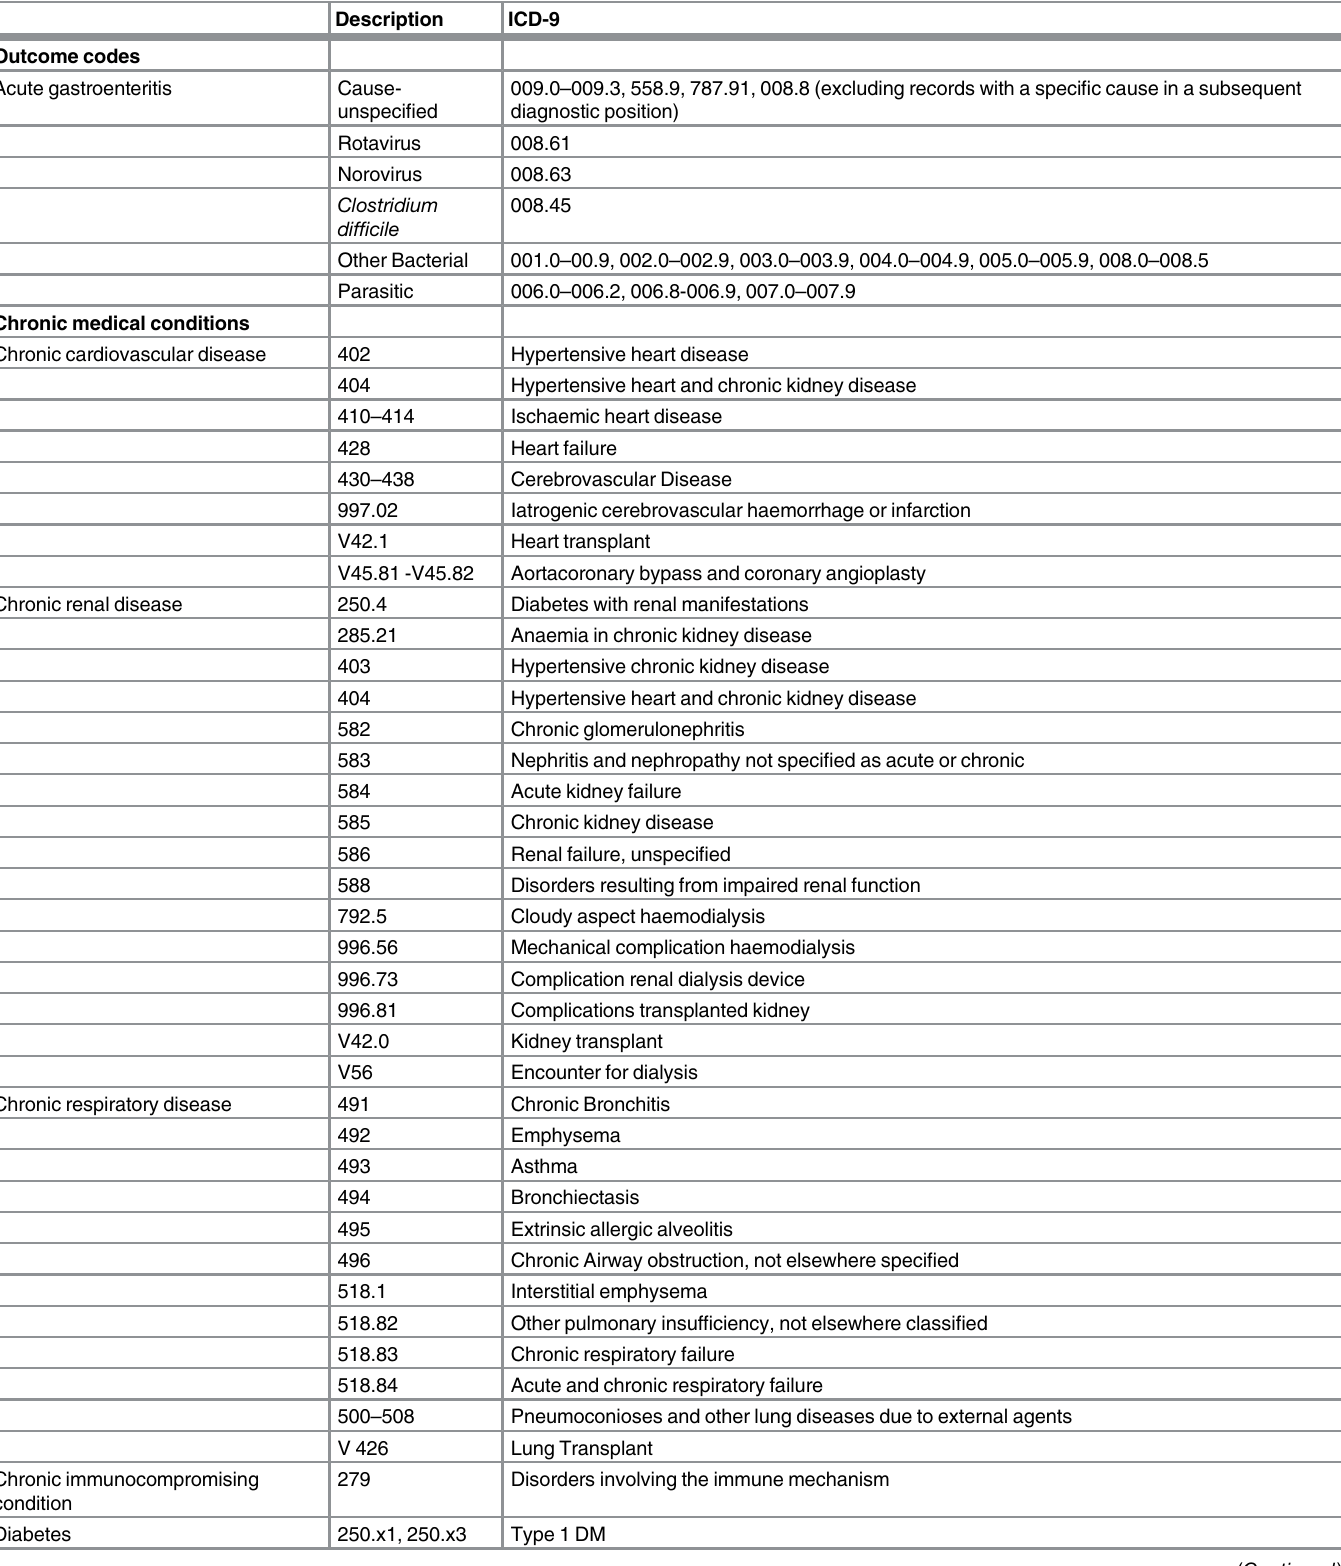
Table 1. Diagnostic codes used to identify gastroenteritis episodes and chronic medical